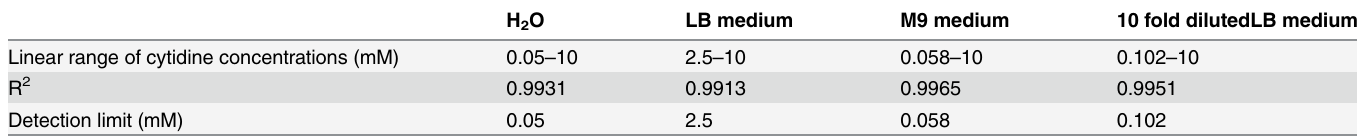
Table 1. Summary of parameters of the cytidine assay by CDA.